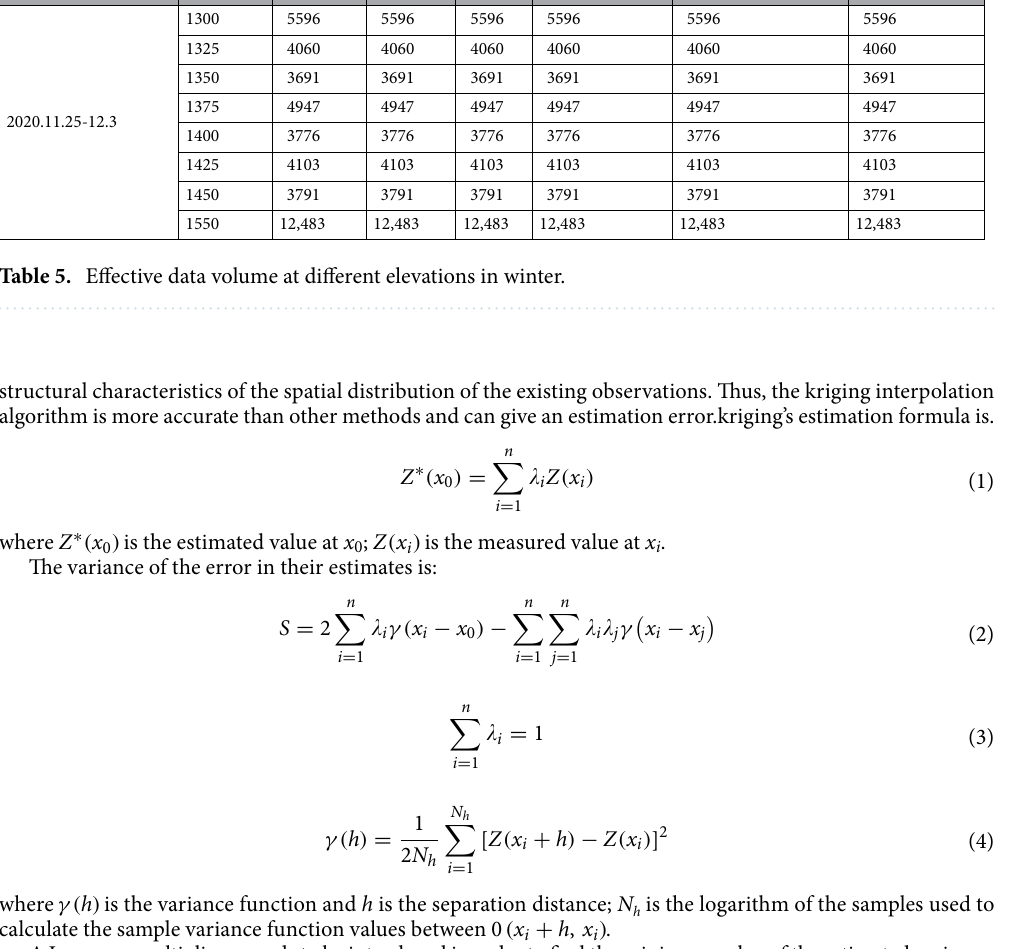
Data collection